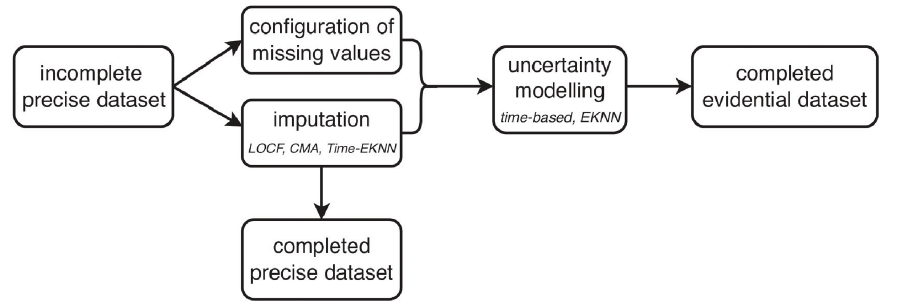
Fig 11. Evidential imputation scheme.